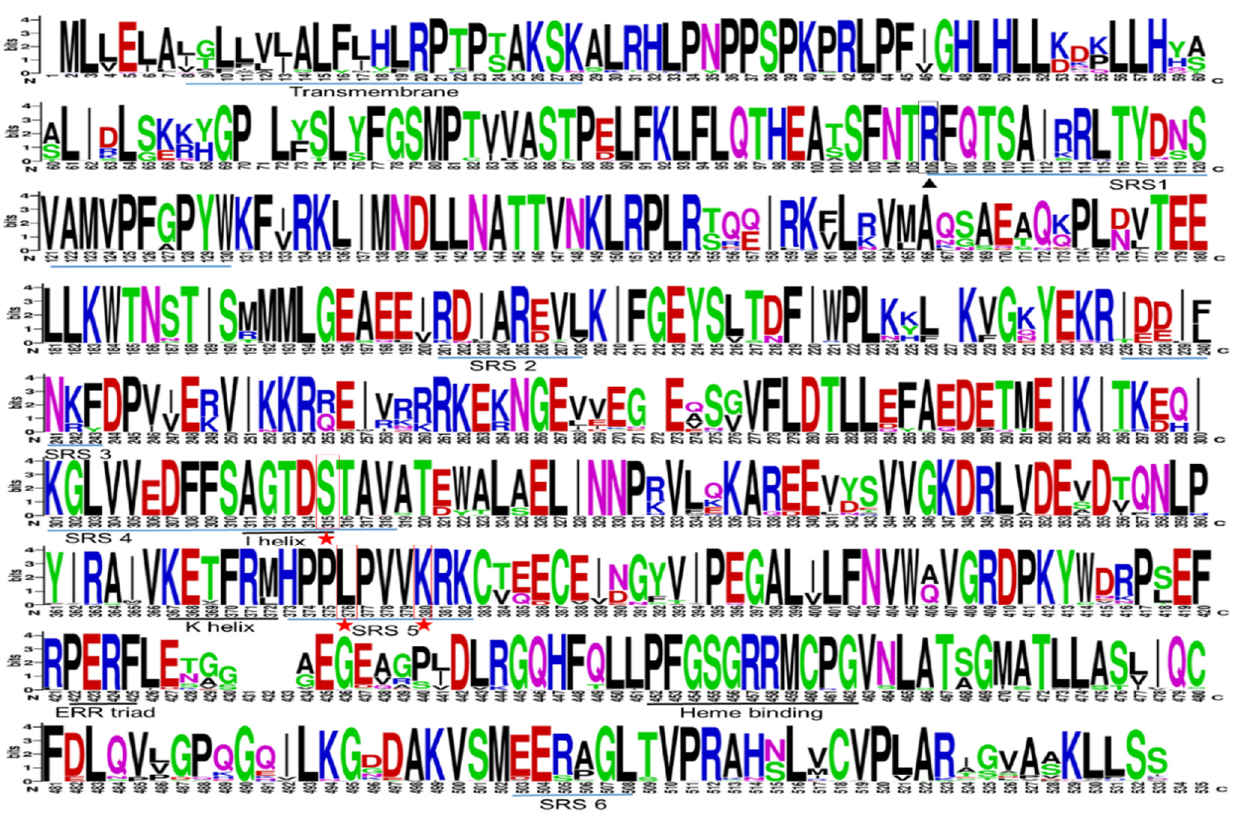
Figure 2. Sequence logos of the multiple sequence alignments of the 139 IFS amino acids sequences: The sequence logos are based on IFS (CYP93C subfamily) amino acids alignment using the Neighbor-Joining algorithm on Geneious Prime. The logos were generated using Weblogo (https://weblogo.berkeley.edu/logo.cgi (accessed on 26 March 2022)). The bit score indicates the information content for each position in the sequence. Hight of the letters designating the amino acid residues at each position represents the degree of conservation. The key conserved motifs are underlined; the black line indicates the P450 motifs, and the blue ones indicate substrate recognition sites (SRSs). Red stars and boxes represent key amino acids, and black triangles and boxes represent important amino acids that also have an important role in catalysis.